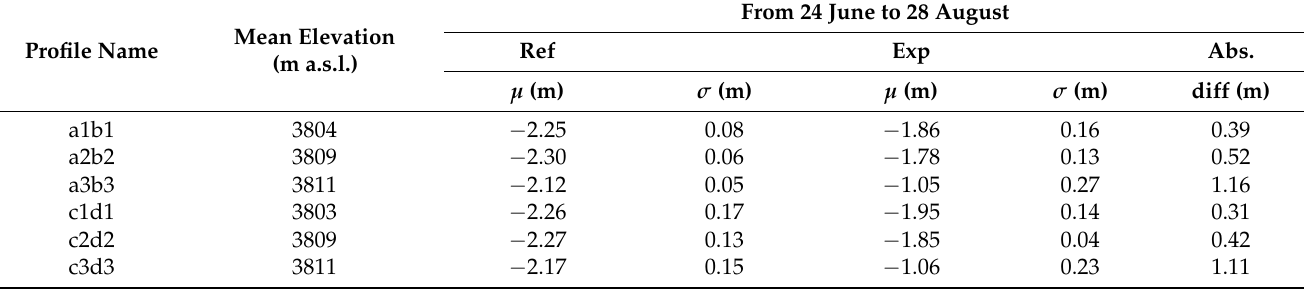
Table 1. Mean elevation of the profiles. The mean ( µ ) and standard deviation ( σ ) of glacier elevation changes as well as absolute differences (abs. diff) of the experimental area (exp) values to the reference area (ref) values are